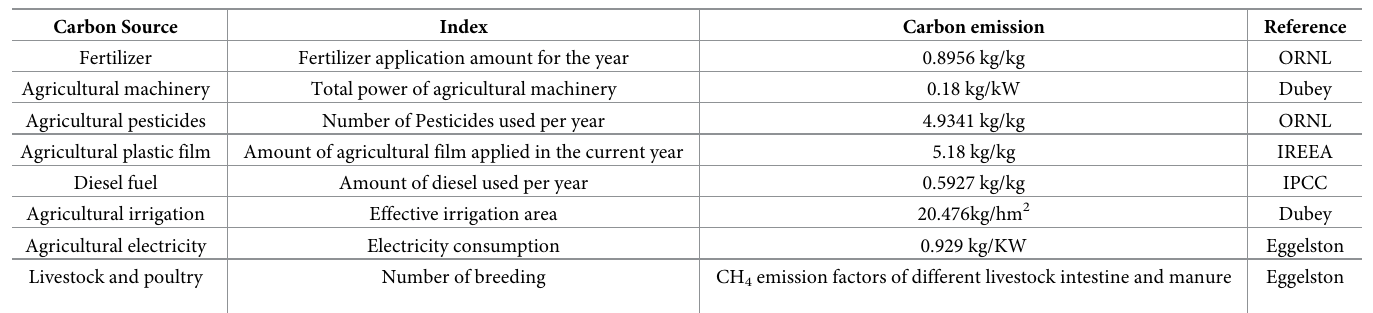
Table 2. Carbon emission sources, emission factors, and